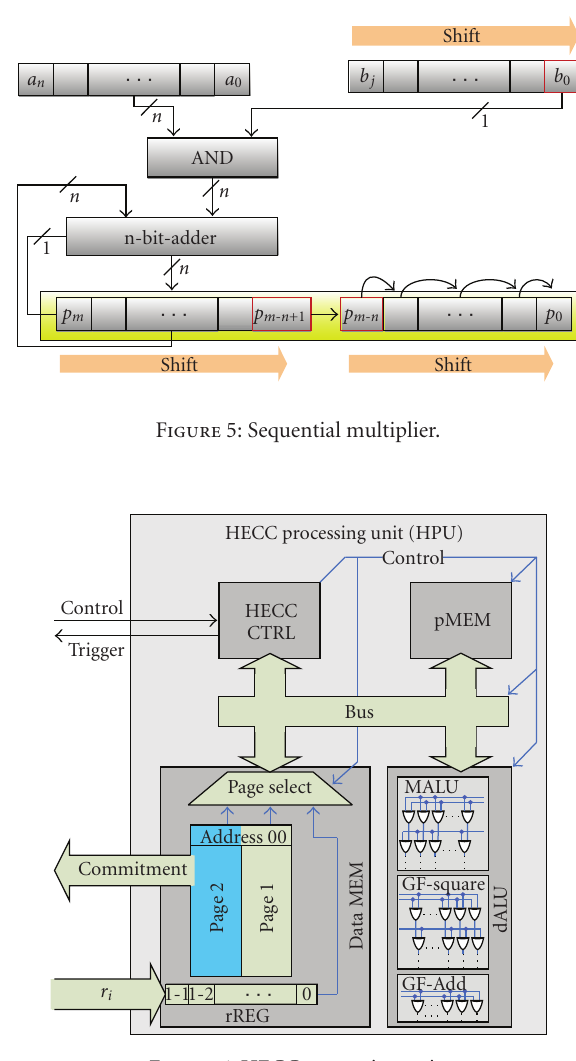
Figure 6: HECC processing